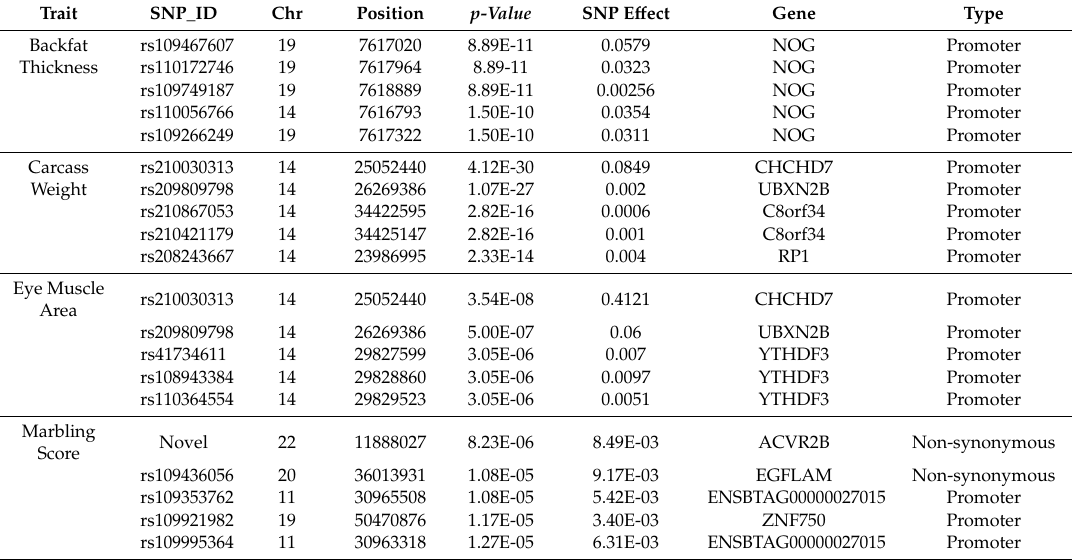
Table 2. Top 5 SNPs associated with carcass traits in